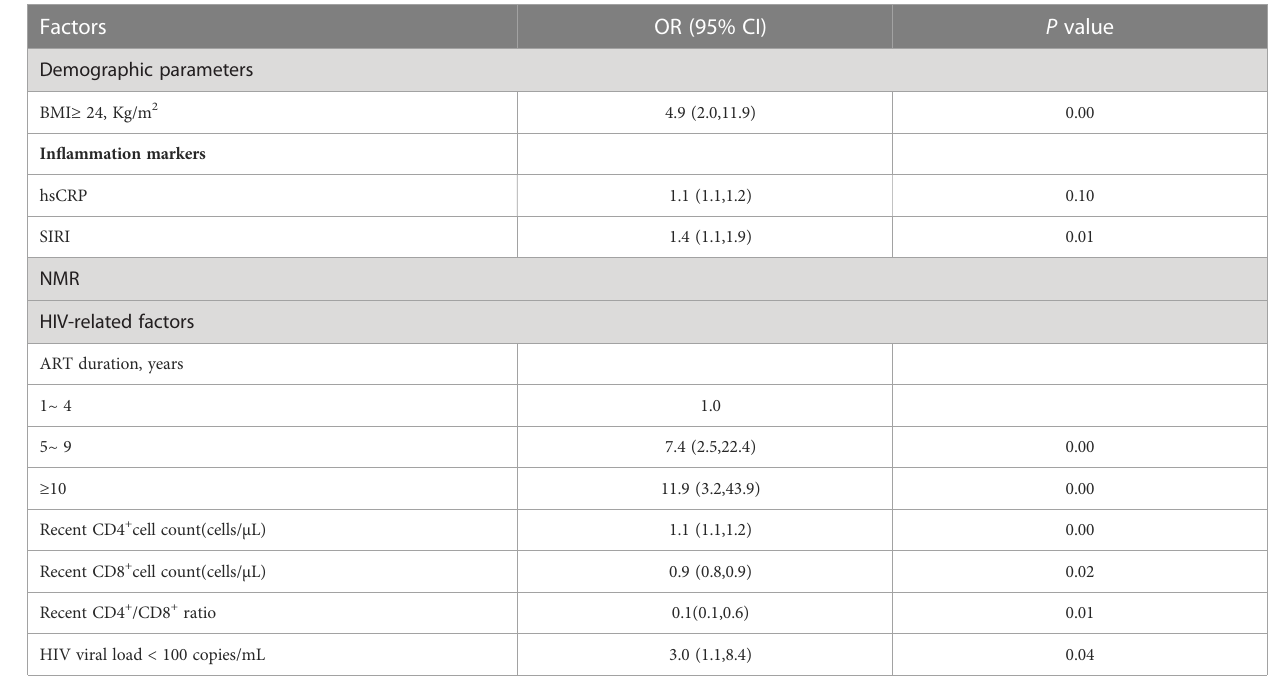
TABLE 4 Factors associated with the risk of